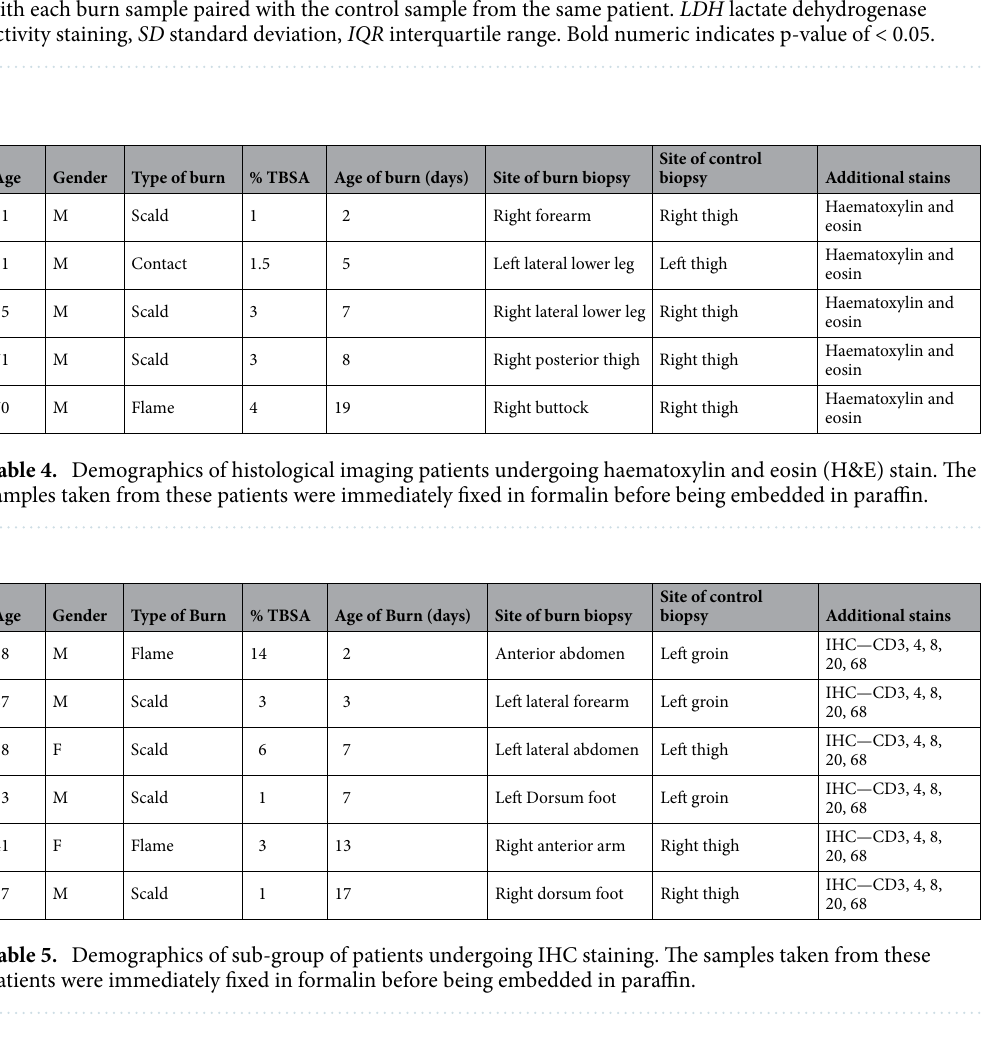
Table 5. Demographics of sub-group of patients undergoing IHC staining. The samples taken from these patients were immediately fixed in formalin before being embedded in paraffin.